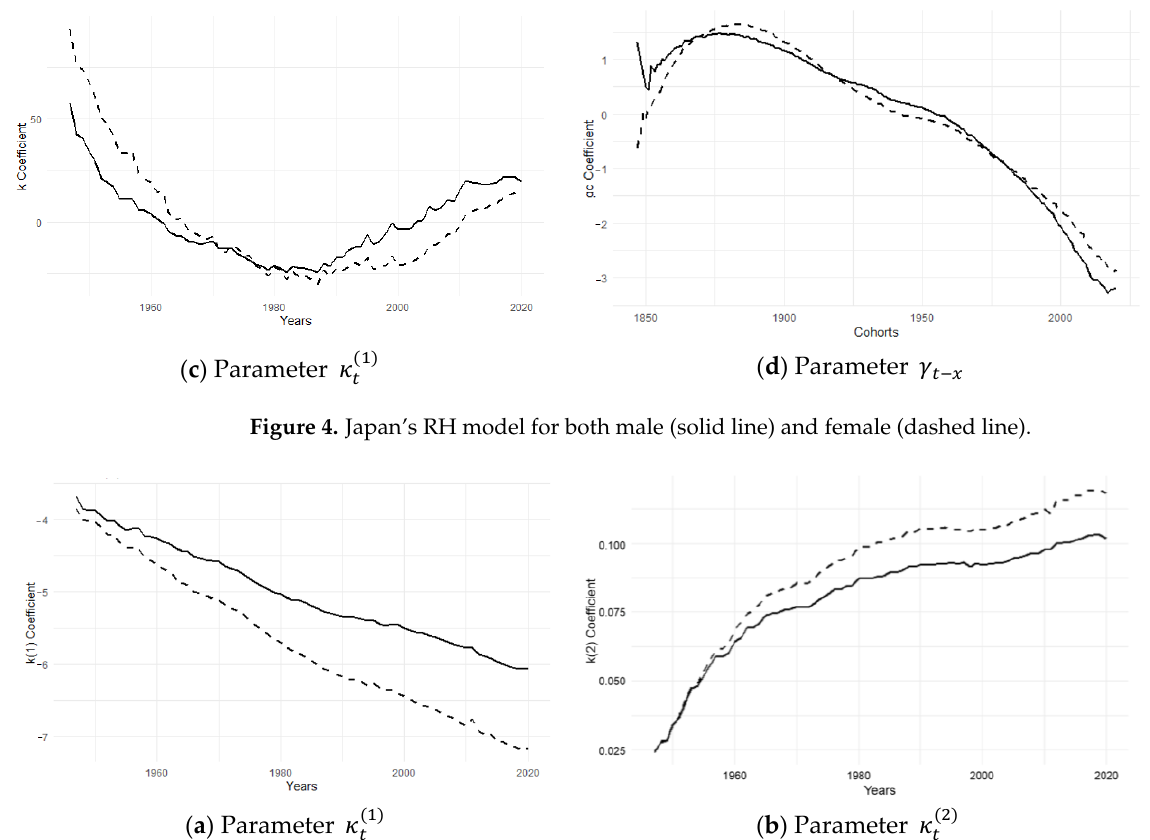
Table 2. Performance of three models before and after the DT.